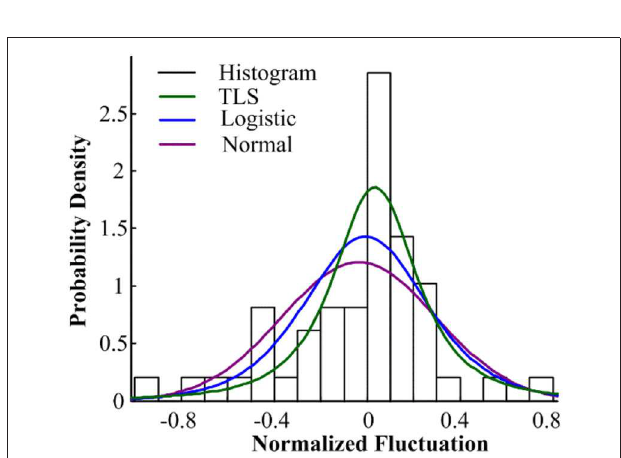
FIGURE 4 | Cumulative probability distribution of random components of PV output in Xichang City on August 9, 2018.